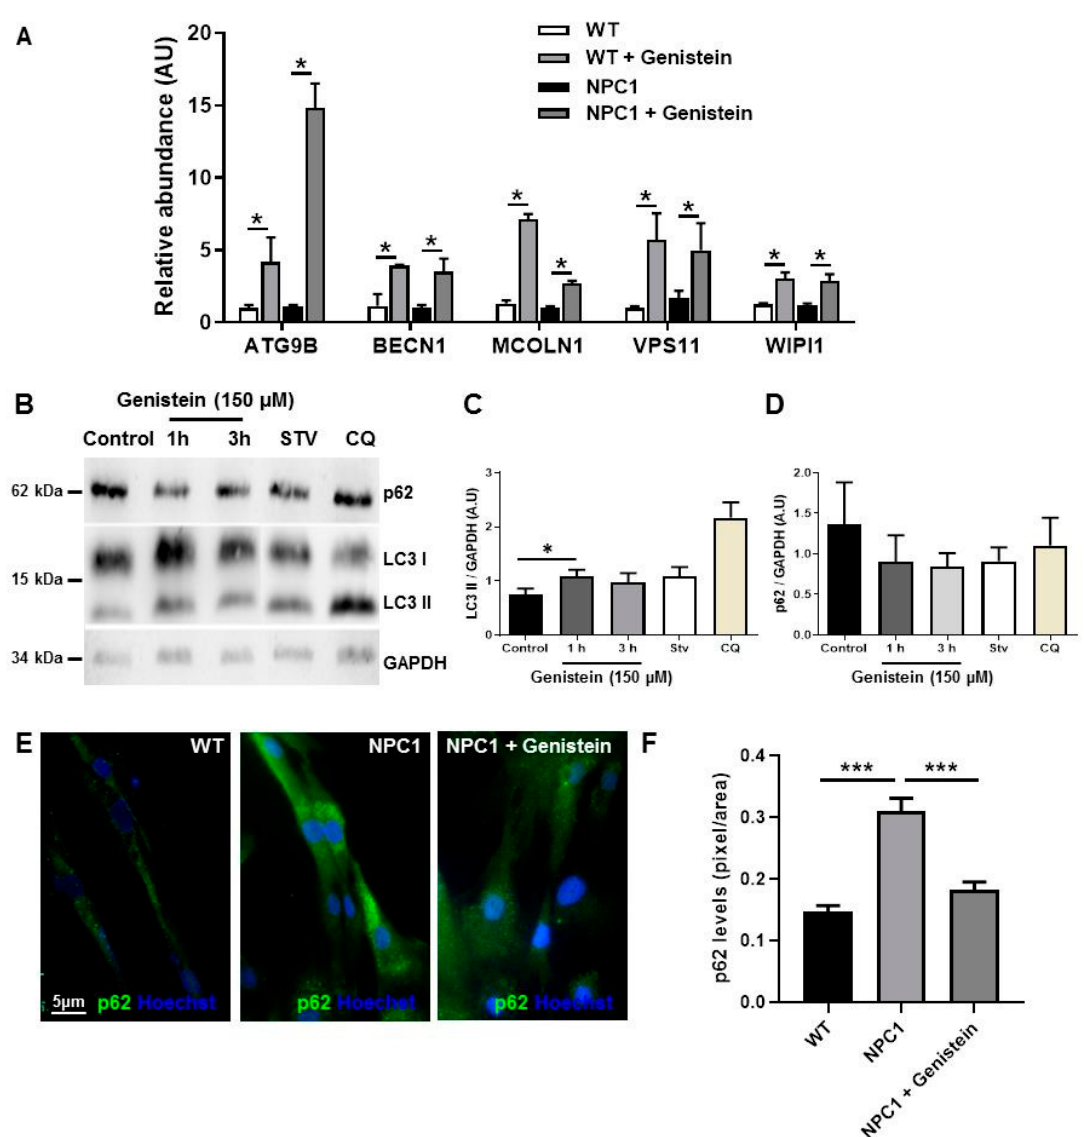
Figure 3. Genistein induces autophagy markers in NPC1 patient fibroblasts. The mRNA levels of the autophagy-related genes, ATG9B , BECN1 , MCOLN1, VSP11, and WIPI1, were measured after 24 h of treatment with 150 µ M of genistein by qPCR ( A ). Representative immunoblot ( B ) and quantification of LC3 ( C ) and p62 ( D ) levels in GM05659 wild type (WT) fibroblast and GM03123 NPC1 patient fibroblast obtained after 1 and 3 h treatment with 150 µ M of genistein. As a positive control for autophagy inhibition and autophagy activation, we used chloroquine 20 µ M and starvation media, respectively, for 3 h. GAPDH was used as loading control. Representative images ( E ) and quantification ( F ) of normalized relative fluorescence intensities for p62 on WT and NPC1 patient fibroblasts obtained after 3 h of treatment with 150 µ M of genistein. The bar graphs show mean ± SEM, * p ≤ 0.05 and *** p ≤ 0.001 versus control analyzed by ANOVA with Tukey test, n = 3 for each experiment (in triplicates for